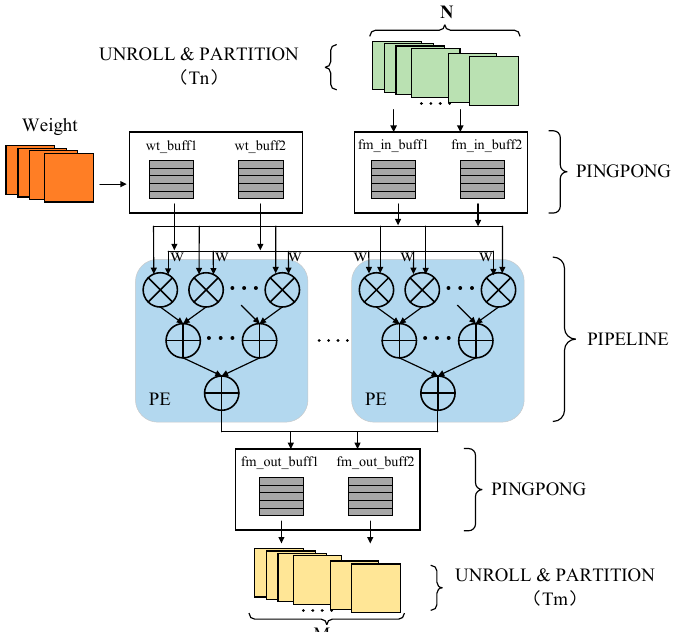
Figure 8. Convolution layer computation